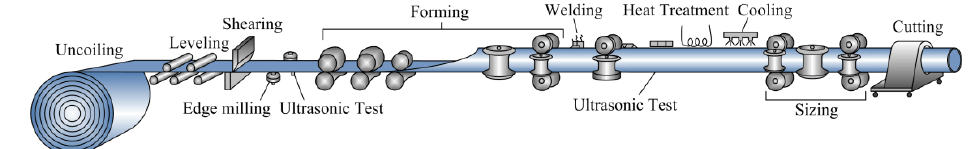
Figure 1. Conventional electric resistance welding (ERW) manufacturing procedures of the steel pipes and tubes.